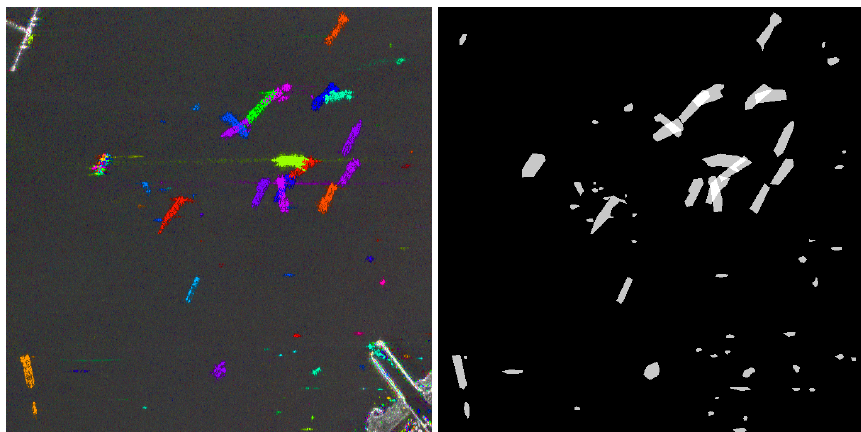
Figure 11. Rapid and EAsy Change detection on Time-series using the coefficient of Variation (REACTIV) method applied to an area of the Grizzly Bay, San Francisco ( Left ) and corresponding manual data entry for Ground Truth ( Right ), 600 × 600 pixels.